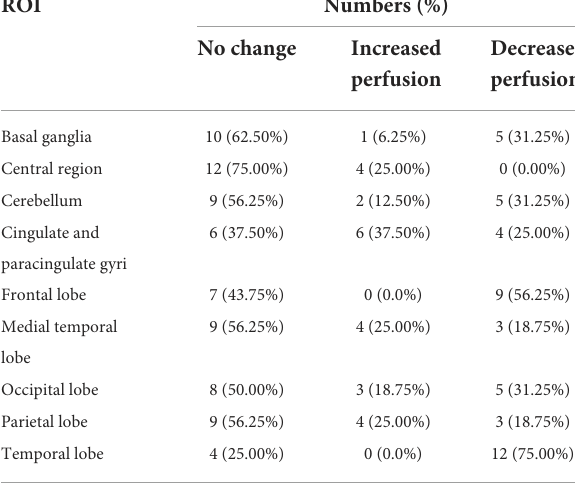
TABLE 5 Regional cerebral perfusion changes of N 2 O abuse resulting in psychiatric